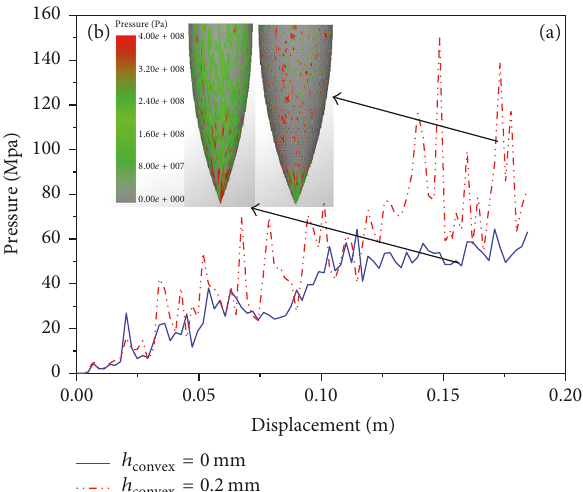
Figure 6: Influence of convex on the contact pressure between projectile and concrete target. The pressure cloud maps were snapped at 0.3 ms while the distance is 0.14 m: (a) contact pressure curves and (b) cloud map of contact pressure distribution.